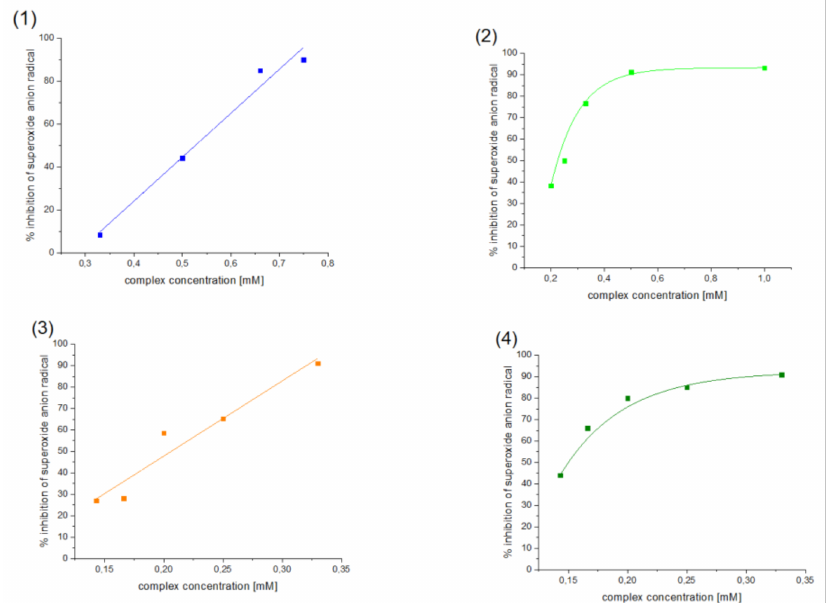
Figure 3. Inhibition of superoxide anion radical by ( 1 ) [VO(dipic)(H 2 O) 2 ] · 2 H 2 O, ( 2 ) [VO(dipic)(phen)] · 3 H 2 O, ( 3 ) [VO(dipic)(bipy)] · H 2 O and ( 4 ) [VOO(dipic)](2-phepyH) · H 2 O.